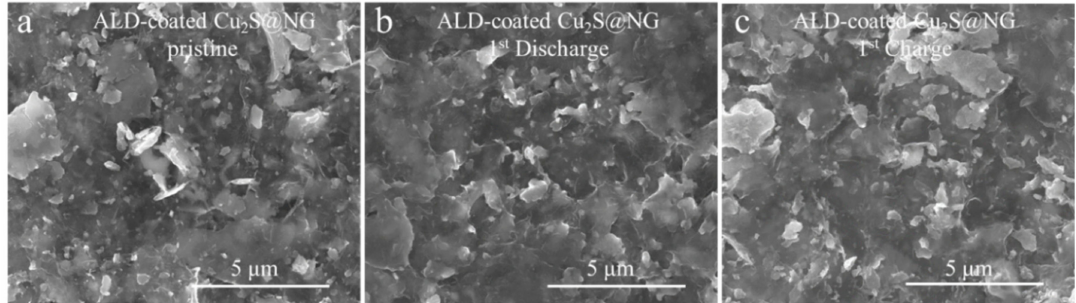
Figure 5. SEM images of the ALD-coated Cu 2 S@NG electrode ( a ) before cycling and after ( b ) 1st discharge and ( c ) 1st